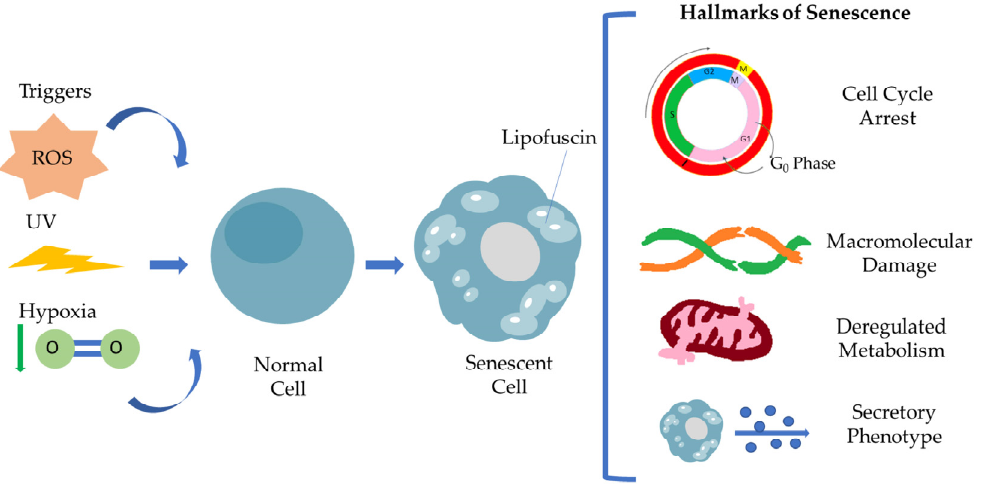
Figure 1. Representation of the hallmarks of cellular senescence. Different stimuli, including ROS, UV irradiation and hypoxia, are able to induce cellular senescence. Senescent cells are characterized by a specific secretory phenotype, cell cycle arrest, macromolecular damage, deregulated metabolism resulting in Lipofuscin